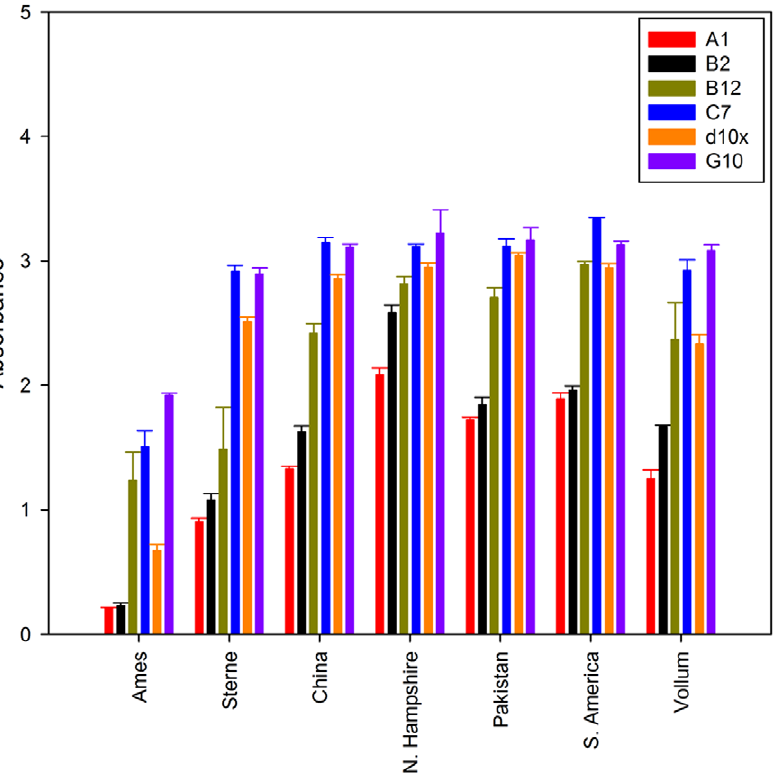
Figure 5. Affinity of sdAbs for Bacillusanthracis strains. Biotinylated sdAbs were tested for their ability to recognize a panel of B. anthracis strains from a number of geographic locations (acquired as irradiated spore preparation from NMRC).